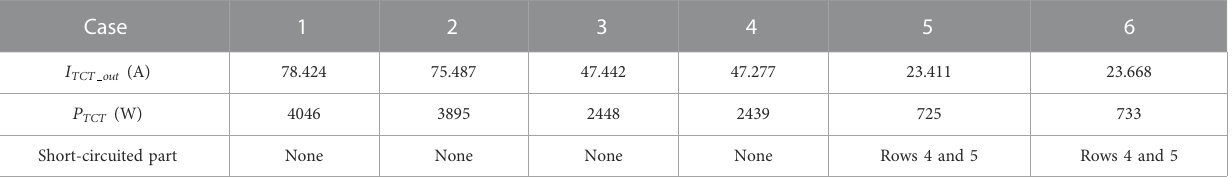
TABLE 3 Estimation of the TCT PV